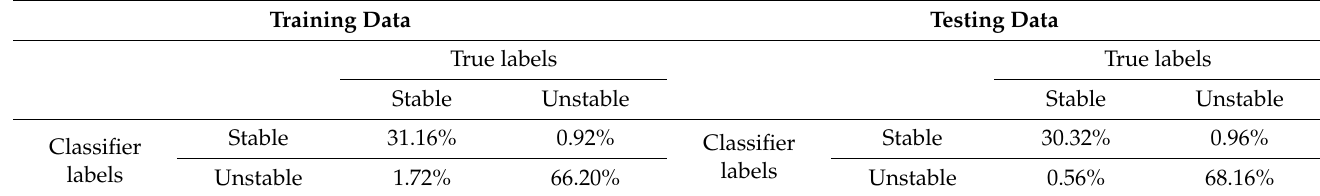
Table 3. SVM confusion matrices on training and testing data.